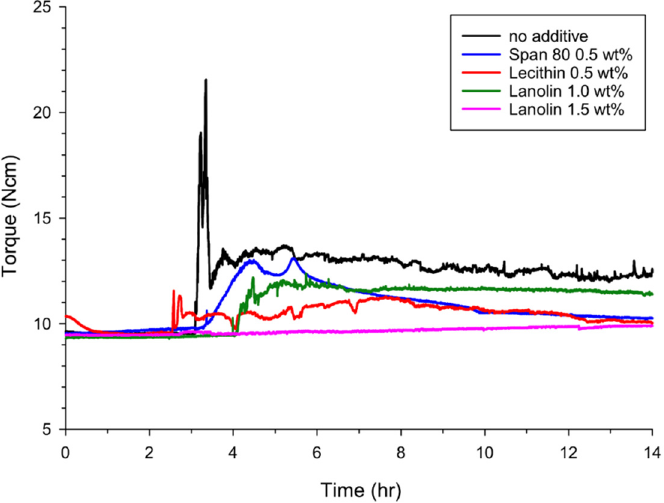
Figure 2. Rotational torques depending on time in the absence or presence of the anti-agglomerant (AA) additives at 30% water cut. 0.5 wt% Span 80, 0.5 wt% lecithin, 1.0 wt% lanolin and 1.5 wt% lanolin were added as the AAs.